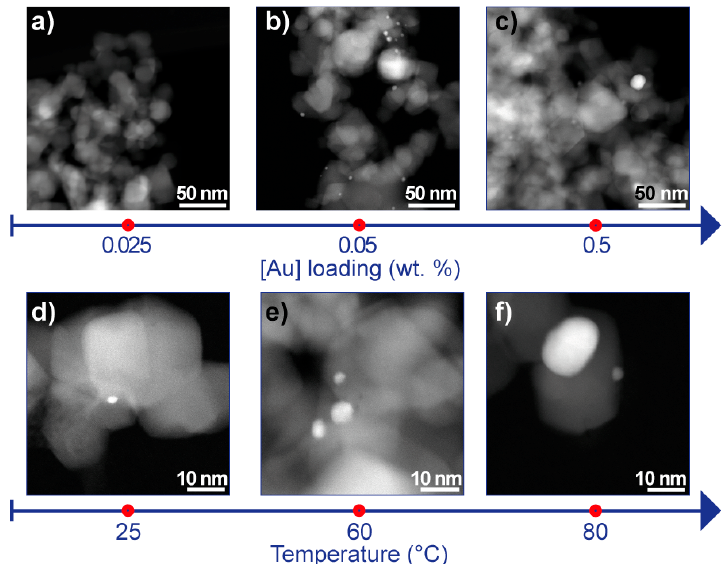
Figure 1. Scanning transmission electron microscopy-high-angle annular dark-field imaging micrographs of Au/TiO 2 nanocomposites synthesized with different Au loadings at 60 °C ( a – c ),